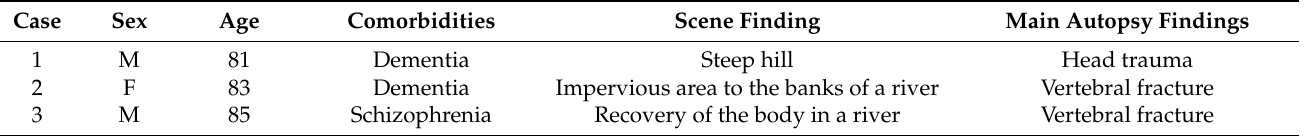
Table 1. Data about autopsy cases reported in our experience with